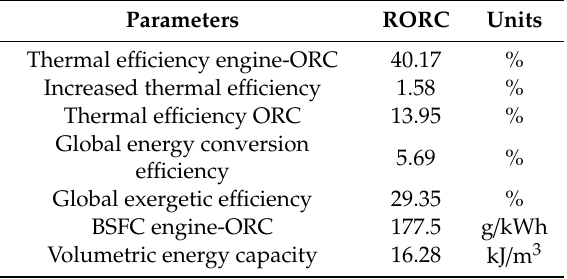
Table 7. Performance parameters obtained for the waste heat recovery (WHR) system based on RORC.